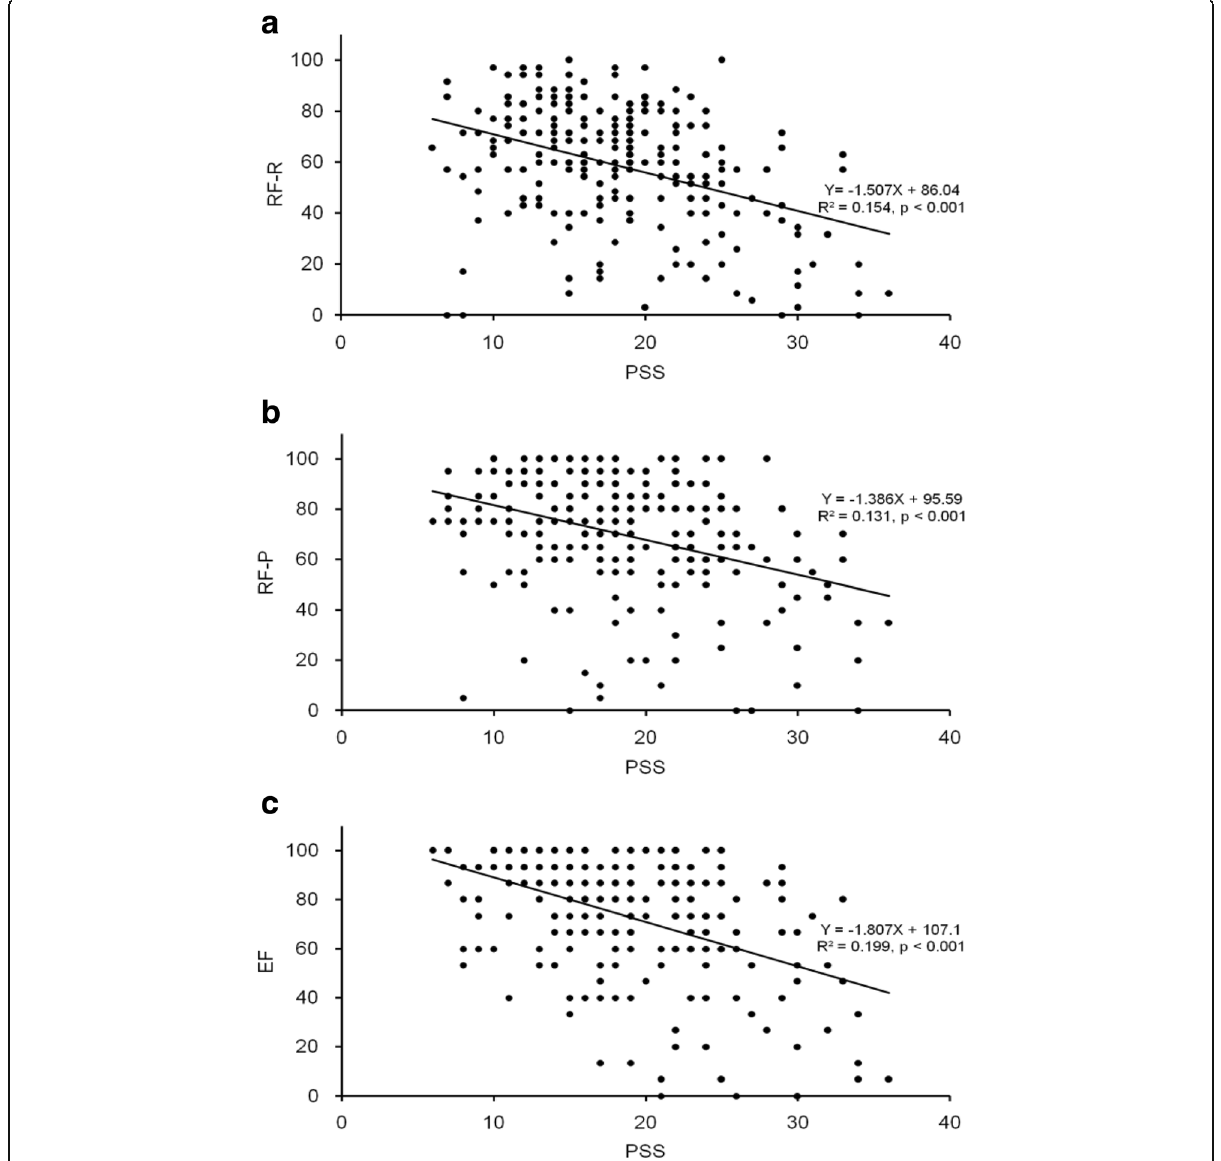
Fig. 1 Relationship between the PSS score and the MSQ score. Three dimensional scores of the MSQ ( a , b , and c ) were inversely correlated with the PSS score ( p < 0.001). PSS: Perceived Stress Scale, MSQ: Migraine-Specific Quality of Life Questionnaire Version 2.1, RF-R: Role Function-Restrictive, RF-P: Role Function-Preventive, EF: Emotional